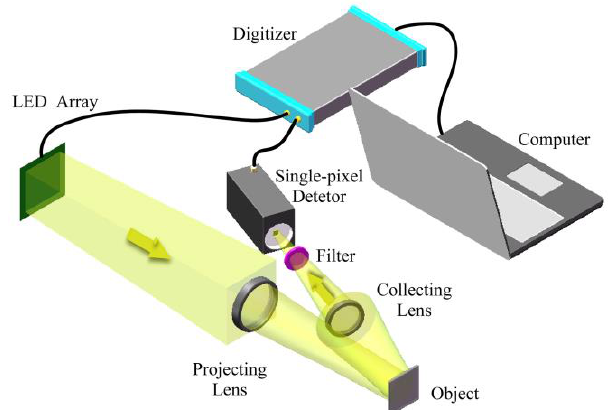
Figure 8. Experimental set-up. A multi-hyperuniform chromatic 32 × 32 × 3 LED array provided structured illumination to sample the object through a projection lens (f = 150 mm). A single-pixel bucket detector (Thorlabs PMT2102) and a digitizer (PicoScope 6404D) collected the reflected light intensity and transferred it to a computer for reconstruction.